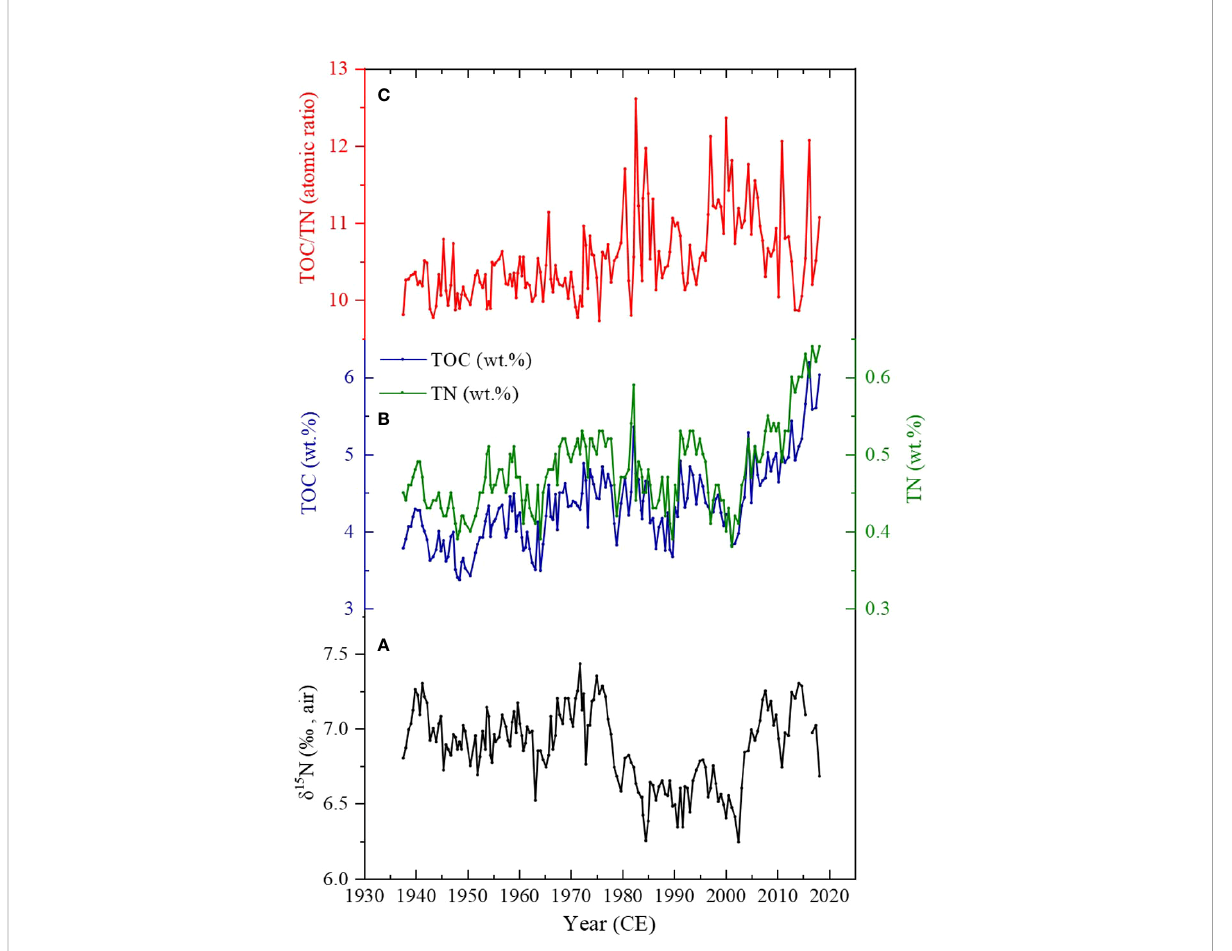
FIGURE 3 TOC, TN, and d 15 N variation of the core SBB-20190629. (A) d 15 N variation in core SBB-190629. (B) Total organic carbon (TOC, wt.%) and total nitrogen (TN, wt.%) records from SBB-20190629. (C) C/N atomic ratio (atom ratio of